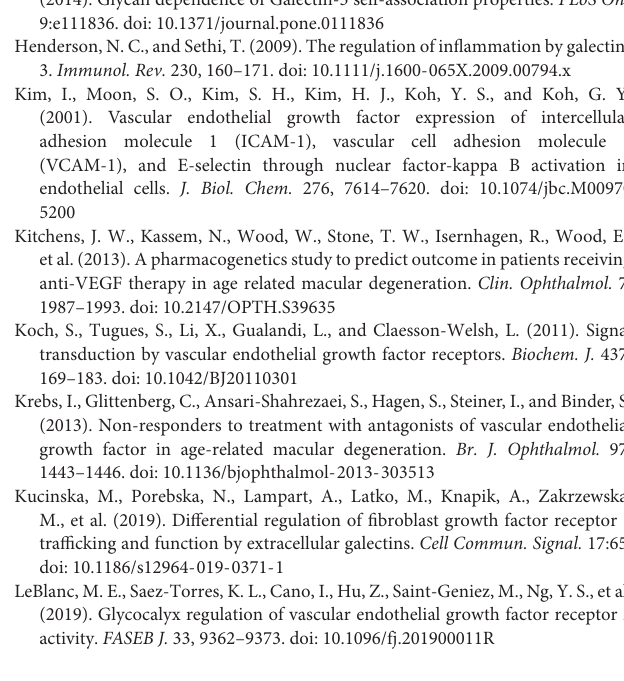
Supplementary Figure 1 | Western blot with protein standard present. A representative western blot was chosen to demonstrate the positioning of the protein standard. The standard used is the Dual Color Precision Plus Protein TM Standards from Bio-Rad, which shows a maximum kDa of 250 and a minimum kDa of 10. Supplementary Figure 2 | Immunofluorescence of cell surface Gal3. HRECs were grown to confluency on gelatin-coated coverslips. Prior to VEGF (10 ng/ml) stimulation, HRECs were starved in serum-free EBM-2 for 2 h. The HRECs were washed with PBS and fixed with 1% paraformaldehyde overnight at 4 ◦ C. The non-permeabilized cells were stained for DAPI, Gal3, and VEGFR2 followed by incubation with the appropriate fluorescent secondary antibodies [Alexa Fluor 594-labeled donkey anti-goat (1:1,000, #A-11058) and Alex Fluor 488-labeled donkey anti-rabbit (1:1,000, #A-21206)]. Images at 20 × magnification were taken using the Zeiss Axioscope (Oberkochen, Germany). The scale bar represents 100 µ m. Expression of Gal3 and VEGFR2 was confirmed on the cell surface, as well as the knockdown of Gal3 using